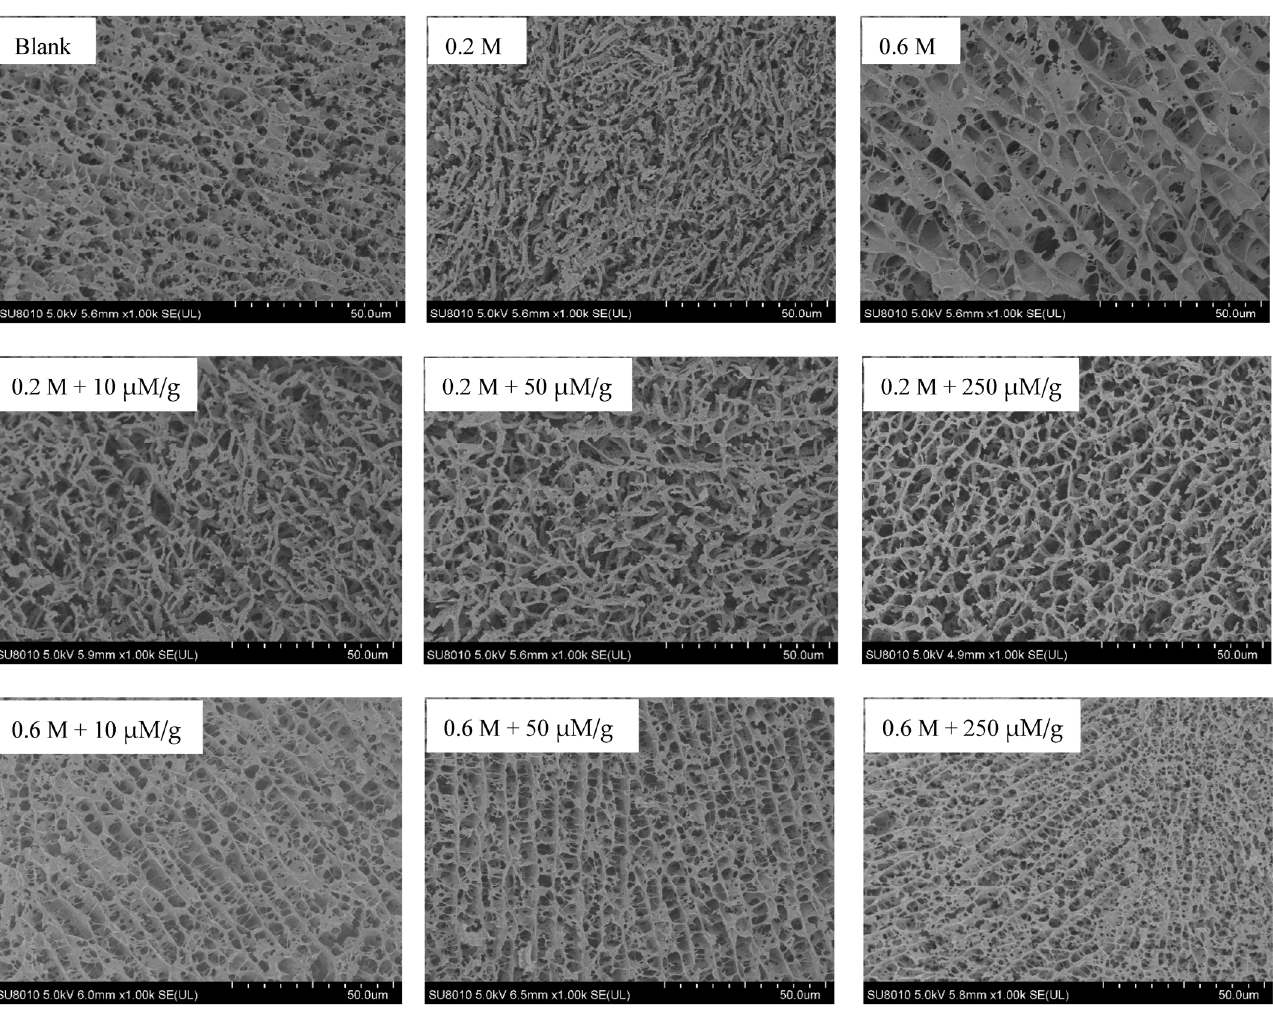
Figure 2. Cryo-SEM images of the non-oxidized MPs gel (blank) and oxidized MPs gels prepared with HYP (10, 50, and 250 µM/g) at di ff erent NaCl concentrations (0.2 and 0.6 M). Scale bars indicate 50.0 µm.